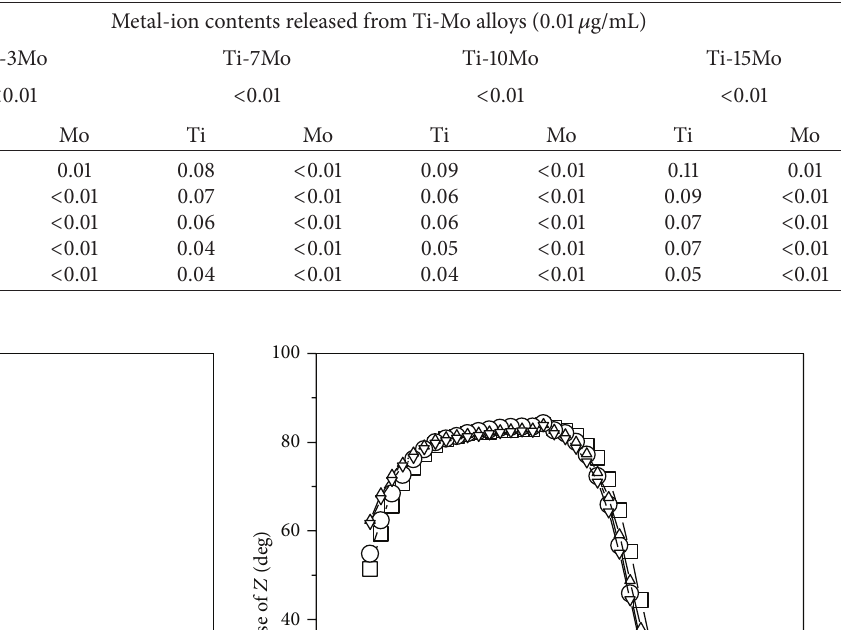
Table 4: Concentrations of metal ions released into two different solutions after various durations at 37 ∘ C.